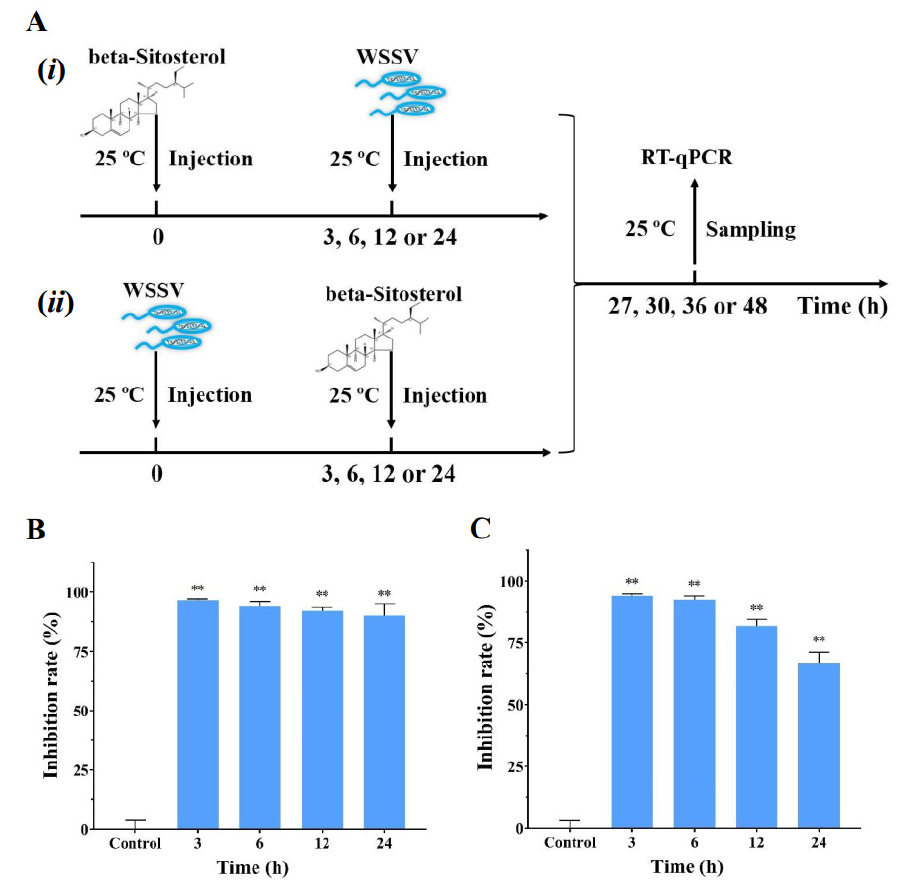
Figure 5. Beta-sitosterol conferred the prophylactic and therapeutic effects against WSSV infection in vivo. ( A ) ( i ) and ( ii ) are the workflows of ( B , C ), respectively. ( B ) The inhibition rate of beta-sitosterol (50 mg/kg) injected before WSSV infection at different times (3, 6, 12, and 24 h). ( C ) The inhibition rate of beta-sitosterol (50 mg/kg) injected after WSSV infection at different times (3, 6, 12, and 24 h). The WSSV-infected group was set as the control group. Data are shown as mean ± SD (n = 5). Asterisks indicate the significant difference between the experimental and control groups (** p < 0.01).